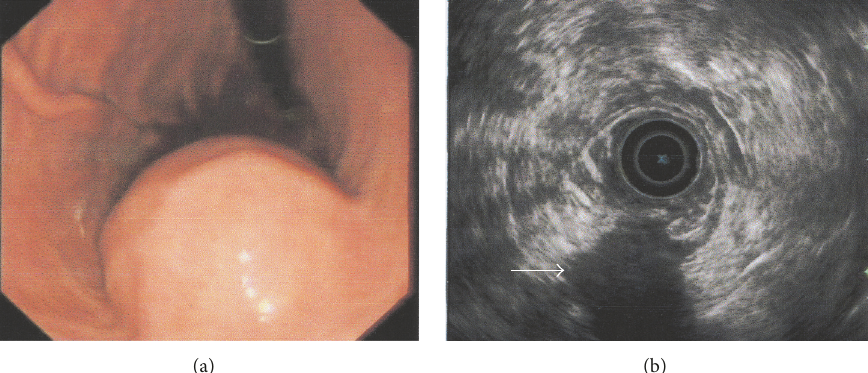
Figure 1: Endoscopic (a) and endosonographic (b) findings in the current case of gastric schwannoma. (a) A round, submucosal mass with an indistinct border was observed at the lesser curvature of the gastric body. (b) On endoscopic ultrasonography, the lesion (white arrow) appeared homogeneous and its echogenicity was lower than that of the normal muscle layer. The mass measured 3.7 × 3.2 cm and originated from the fourth layer.